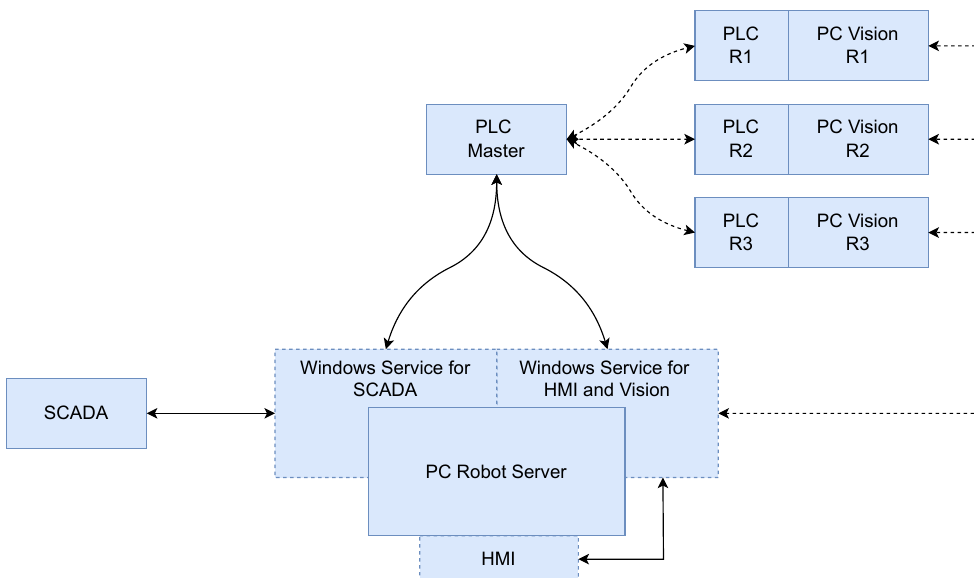
Figure 7. Schematic representation of the architecture of the software